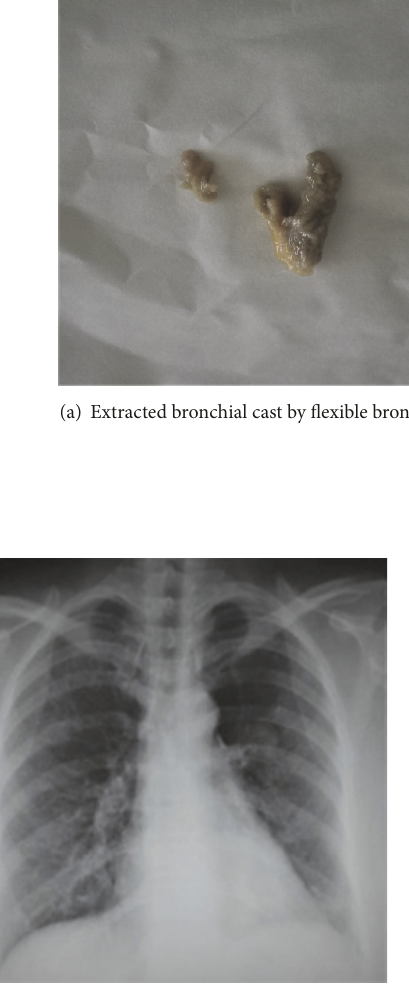
Figure 4: Control of chest-x-ray after cast rejection revealed complete left lung